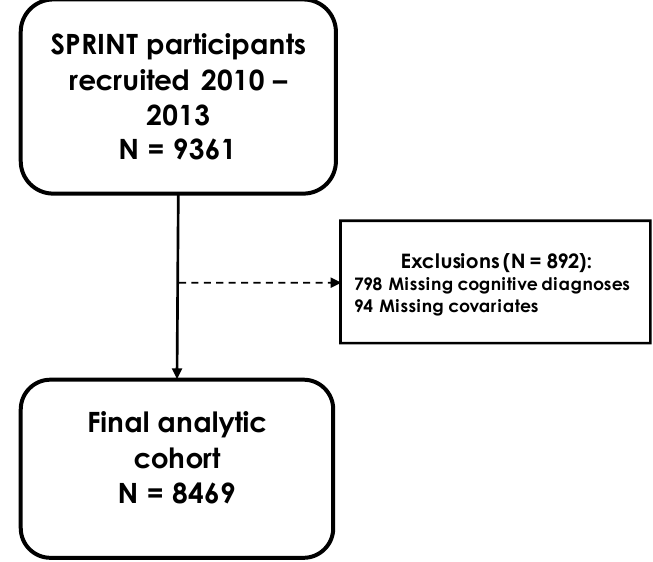
Figure 1. SPRINT participant flow chart.